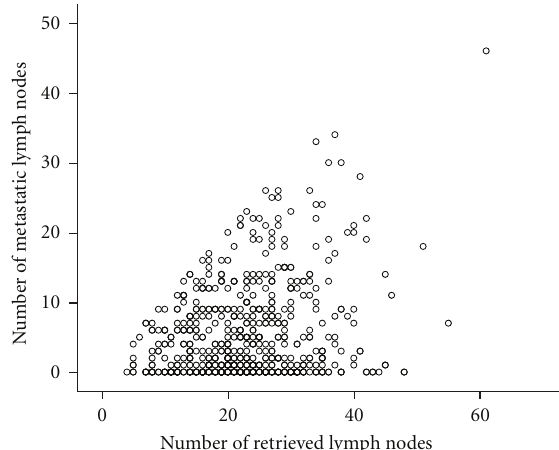
Figure 2: Pearson’s correlation tests. Significant correlation bet- ween the number of lymph node metastases and retrieved lymph nodes ( r = 0 . 252, P < 0 .